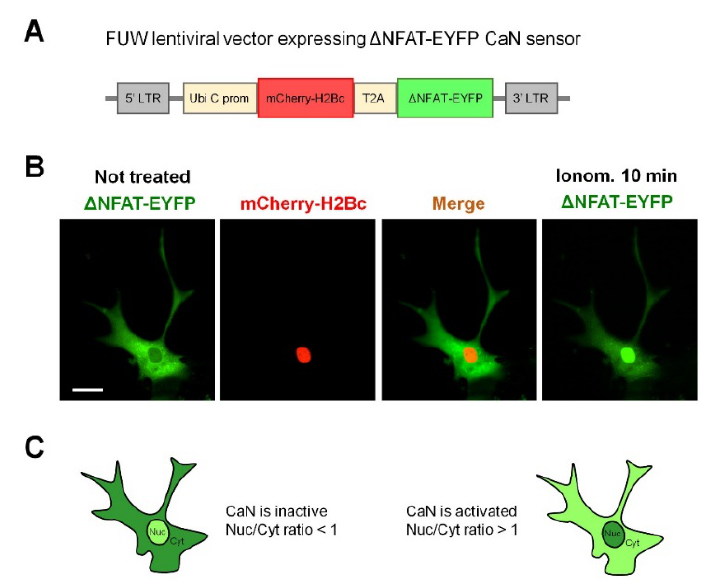
Figure 1. Validation of lentiviral vector expressing NY CaN sensor in astrocytes. ( A ) A scheme of lentiviral vector expressing Δ NFAT-EYFP (NY) CaN sensor. ( B ) Hippocampal astrocytes were transduced with NY CaN sensor and then stimulated with 2 μM ionomycin. Nuclear translocation of NY in astrocyte was observed after 10 min of incubation. A representative astrocyte is shown from three independent preparations. Bar, 10 μm. ( C ) Quantification of nuclear-to-cytosol ratio (Nuc/Cyt ratio) of NY in the green channel. CaN was considered inactive with Nuc/Cyt ratio <1, while Nuc/Cyt ratio >1 indicates CaN activation.